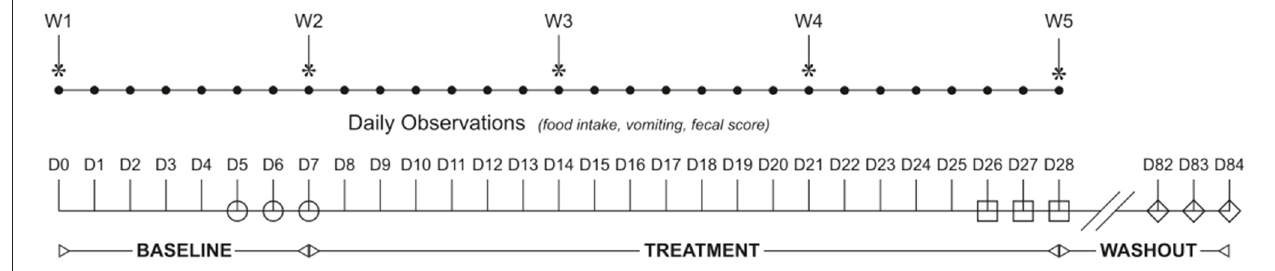
FIGURE 1 | Study design flowchart. The study spanned 84 days (D1–84) and was broken into three study periods: baseline (D1–D7), treatment (D8–D28), and washout (D29–84). Dogs were randomized to receive enrofloxacin (10 mg/kg qd) and metronidazole (12.5 mg/kg BID), followed 1h later by placebo or a synbiotic combination (BID) PO during treatment. Feces were collected from each dog once daily on the last 3 days of baseline (open circles), treatment (open squares), and recovery (open diamonds).